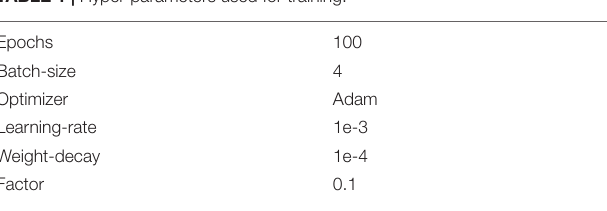
TABLE 1 | Hyper-parameters used for